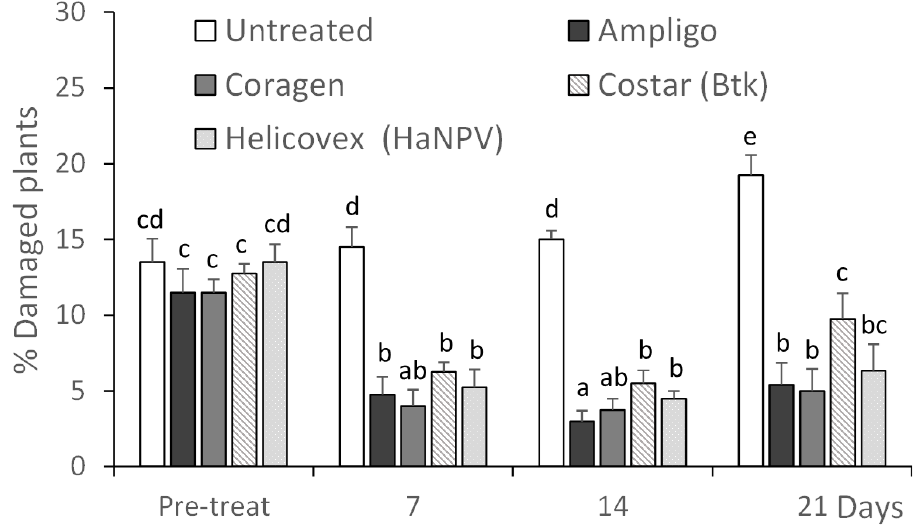
Figure 1. Percentage of damaged plants (mean ± SD) assessed in a field with mixed infestation of H. armigera (dominant species) and O. nubilalis , before (Pre-treat) and after insecticidal applications with different products. Different letters above bars indicate significant differences among means (ANOVA Mixed Proc., p < 0.05).